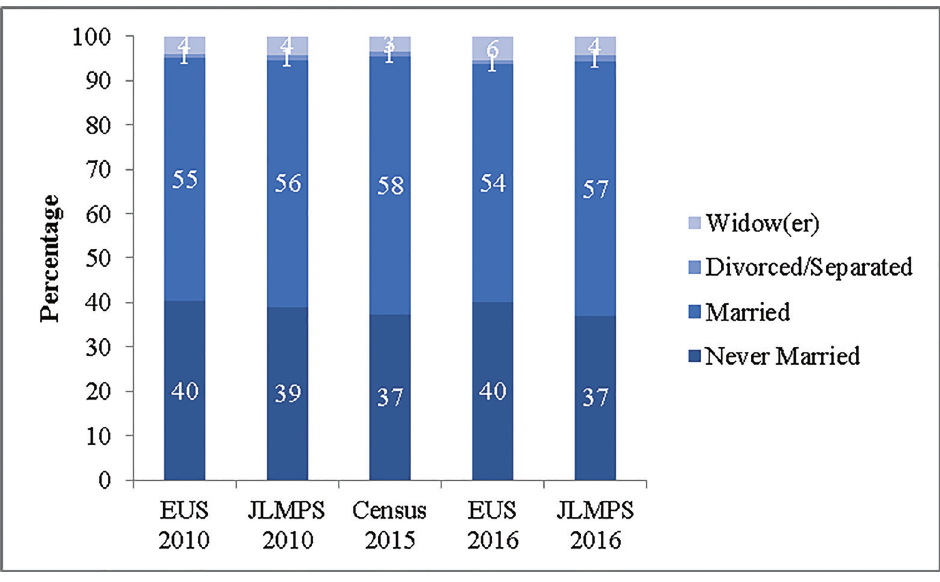
Source : Authors’ calculations from EUS 2010 and 2016, JLMPS 2010 and 2016, and Census: Department of Statistics (Jordan) (2015e). EUS, Employment and Unemployment Survey; JLMPS, Jordan Labor Market Panel